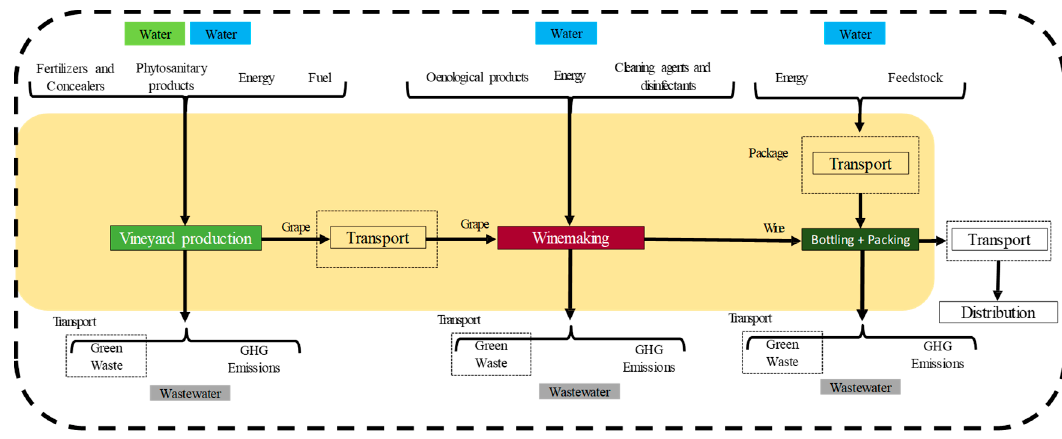
Figure 2. Main processes in wine production and its most relevant inputs and outputs.